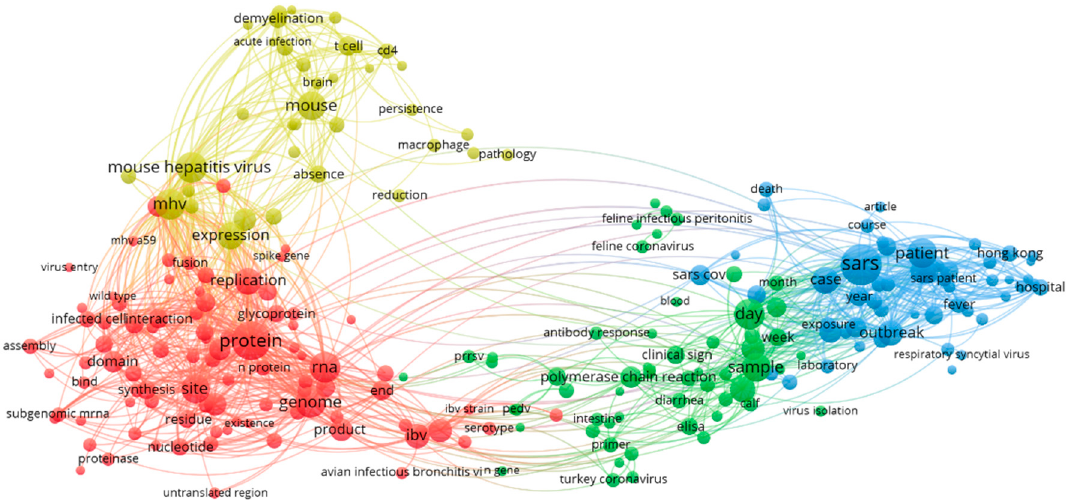
Figure 2. 2000 – 2003 term co-occurrence map.